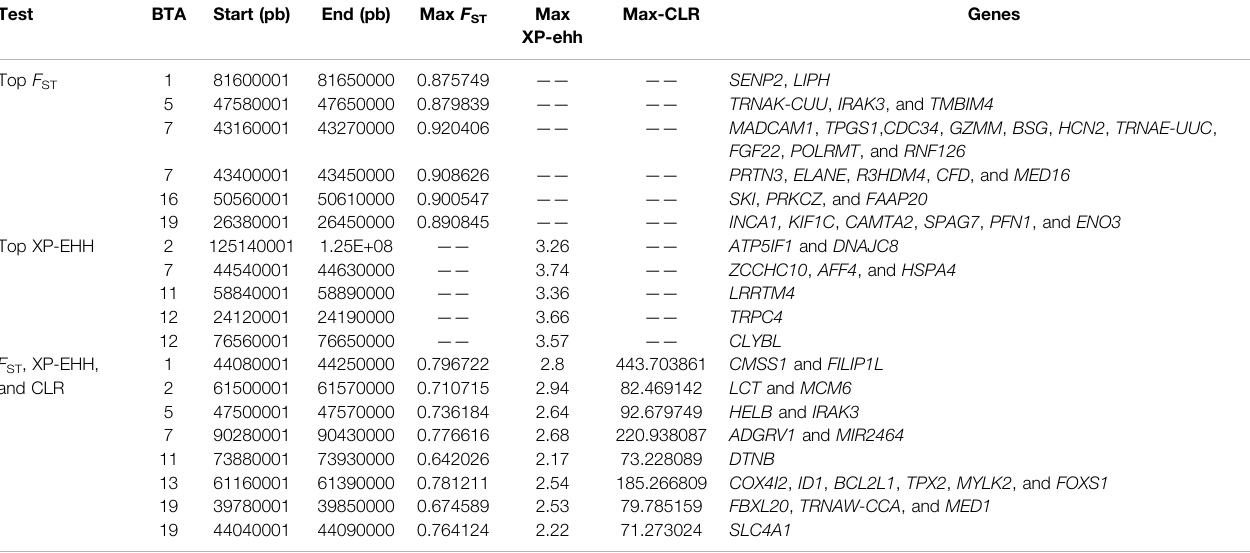
TABLE 1 | Genomic regions and associated genes putatively under selection identi fi ed using F ST , XP-EHH, and CLR statistics.